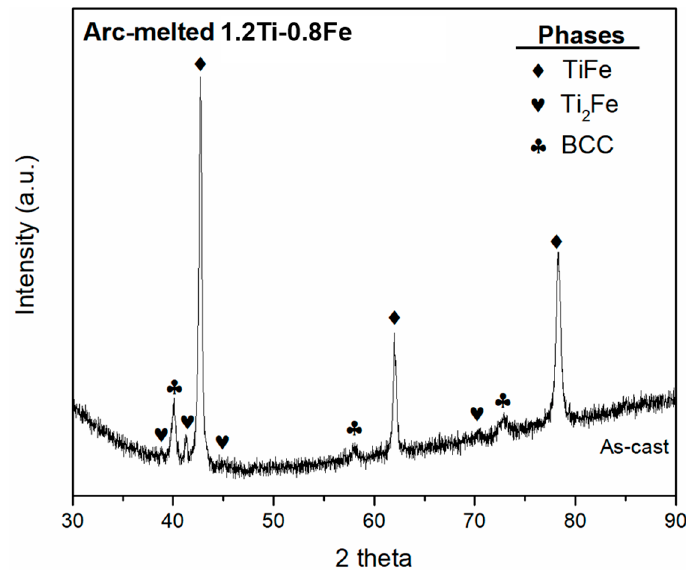
Figure 7. X-ray diffraction patterns of the arc-melted 1.2Ti-0.8Fe.